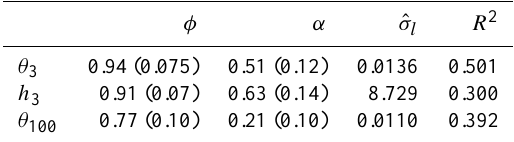
Table 3. Parameter estimates of the ARMA(1,1) model, for θ 3 , h 3 , θ 100 and goodness of fit R 2 . In parenthesis the standard deviations of the estimated